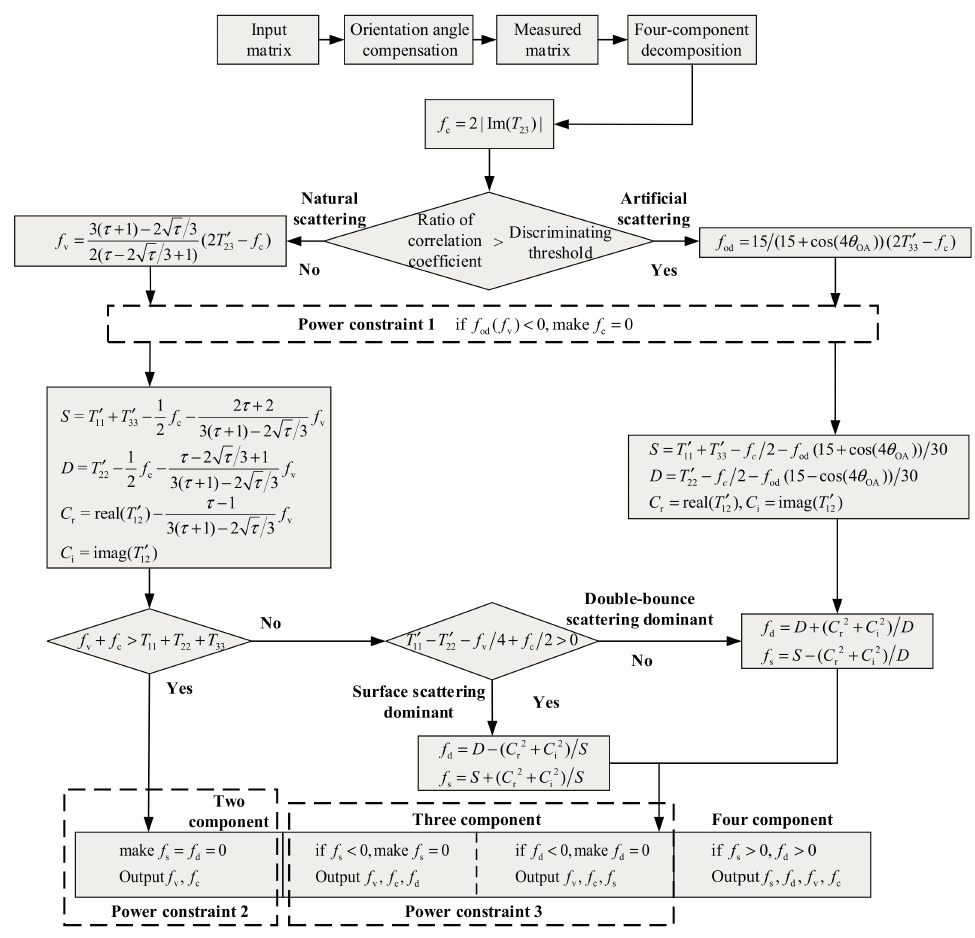
Figure 2. General scheme of the proposed